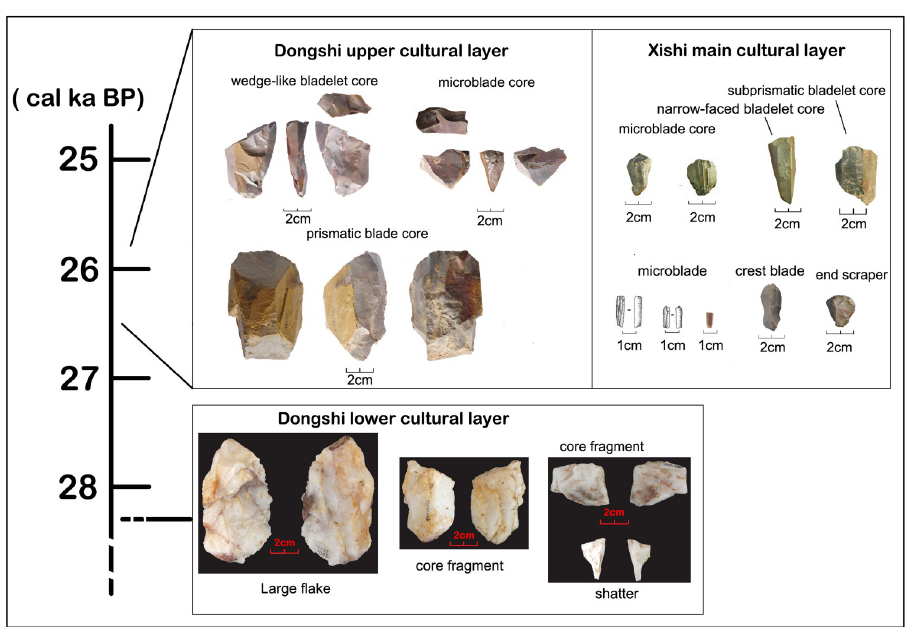
Fig 5. The assemblages associated with the Dongshi lower cultural layer and the Dongshi upper cultural layer/ Xishi main cultural layer. https://doi.org/10.1371/journal.pone.0275162.g005 microblade, as well as some specific features along the dorsal and ventral surface of micro- blades (like the maximum width at the shoulder below the bulb, the small point-like pressure bulb, straight profile, and the curved distal section ending in “feathering”) indicate that unlike blades or bladelets which were often produced by soft hammer percussion, the microblades